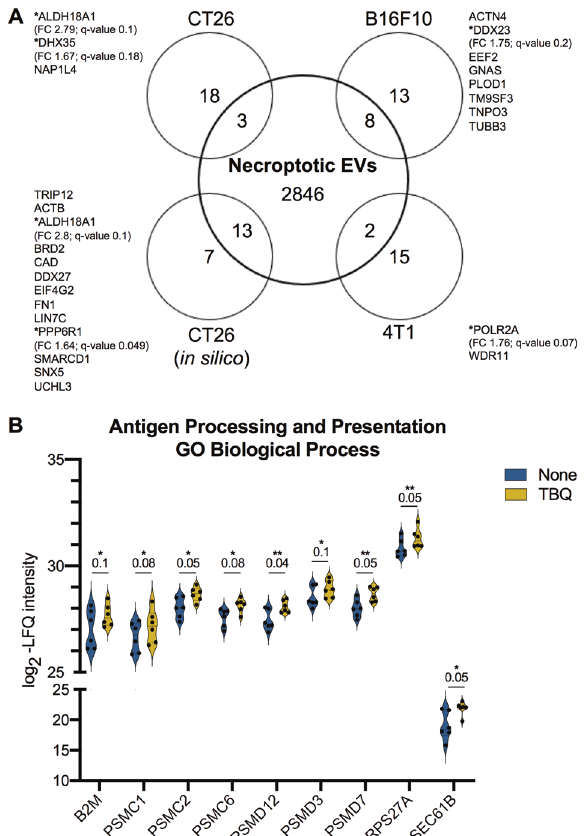
Fig. 6 Necroptotic EVs contain tumor neoantigens. A Venn diagram of total proteins identi fi ed in necroptotic EVs compared with the published tumor neoantigens from B16F10, CT26, 4T1 models or CT26 in silico prediction [58]. TBQ EV-enriched proteins with FDR cutoff of 0.2 are marked with * . Fold change (FC) and Q - value are mentioned for each. B Violin plots showing log 2 -LFQ intensity of the TBQ EV-enriched proteins annotated as the enriched GO biological process “ antigen processing and presentation via MHC class I ” . Q -value is mentioned individually above each plot, * Q < 0.1, ** Q < 0.05. EVs, extracellular vesicles; FDR, false discovery rate; FC, fold change; TBQ, TNF- α , Birinapant, and QVD-OPh; GO, gene ontology; LFQ, label-free quanti fi cation; MHC, major histocompat- ibility